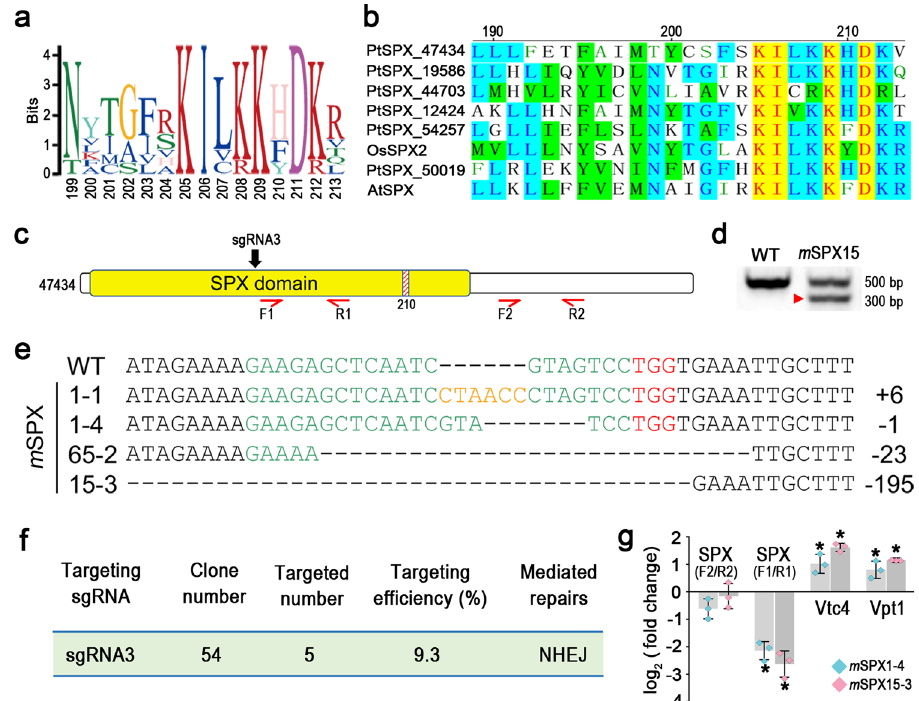
Fig. 1 The identi fi cation and successful knockout of SPX gene. a Graphical motif representation showing conserved amino acid residues of the SPX domain. b Alignment of SPX conserved sites with land plants. Identical residues are yellow-shaded while chemically similar ones are green-shaded. Included in the alignment are the six amino acid sequences from P. tricornutum , one from Oryza sativa Japonica Group (OsSPX2, XP_015614909.1), and one from Arabidopsis thaliana (AtSPX, NP_567674.1). c Schematic diagram showing the N-terminal SPX domain (yellow) and the effective sgRNA-targeting site (sgRNA3, arrow). The hatched area with number 210 indicates the location of the conserved domain shown in a , b . The red horizontal arrows indicate primers designed for RT-qPCR assay of SPX expression (results shown in g ). F1 and R1 are located near the mutation target site whereas F2 and R2 are located far downstream from the mutation target site. d Target region of SPX gene ampli fi ed with speci fi c primers, with the red arrowhead showing a deletion mutant band. e Sequence alignment of representative mutant clones with the wild type (WT). The sgRNA sequences, PAM sequences, and inserted sequences are labeled in green, red, and yellow, respectively. Clones of sequence 1-4 ( m SPX1-4) and sequence 15-3 ( m SPX15-3) were selected for downstream analyses. f Summary of on-target rate (targeting ef fi ciency) in SPX knockout. NHEJ non-homologous end joining. g The expression of P stress- induced SPX-related genes in P. tricornutum m SPX1-4 and m SPX15-3 under P + condition. Two SPX mutants ( m SPX1-4 and m SPX15-3) were selected for comparisons with WT on the third day of inoculation into P + growth medium ( n = 3). Error bars, SD. Statistically signi fi cant changes in gene expression (*) in m SPX relative to WT is based on one-way ANOVA test ( p <